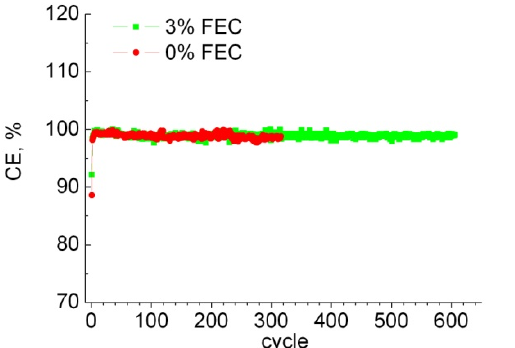
Figure 3. Dependence of Coulomb efficiency on the cycle number for samples with 0% and 3% FEC.